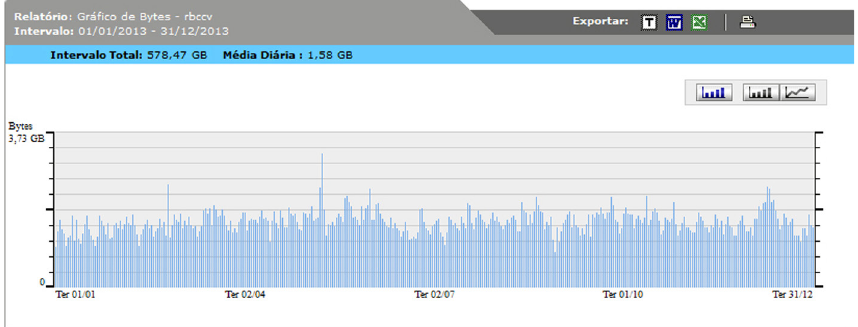
Fig. 3 - Graph showing Gigabytes (GB) transferred in RBCCV / BJCVS site in 2013.